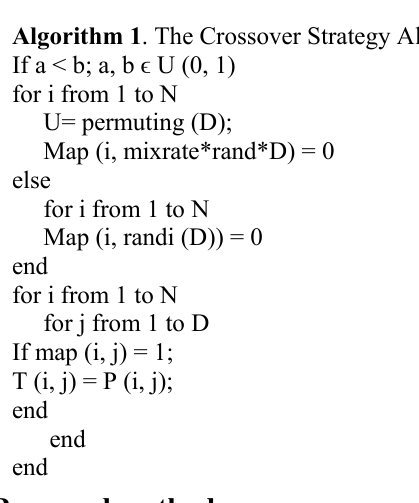
Algorithm 1 . The Crossover Strategy